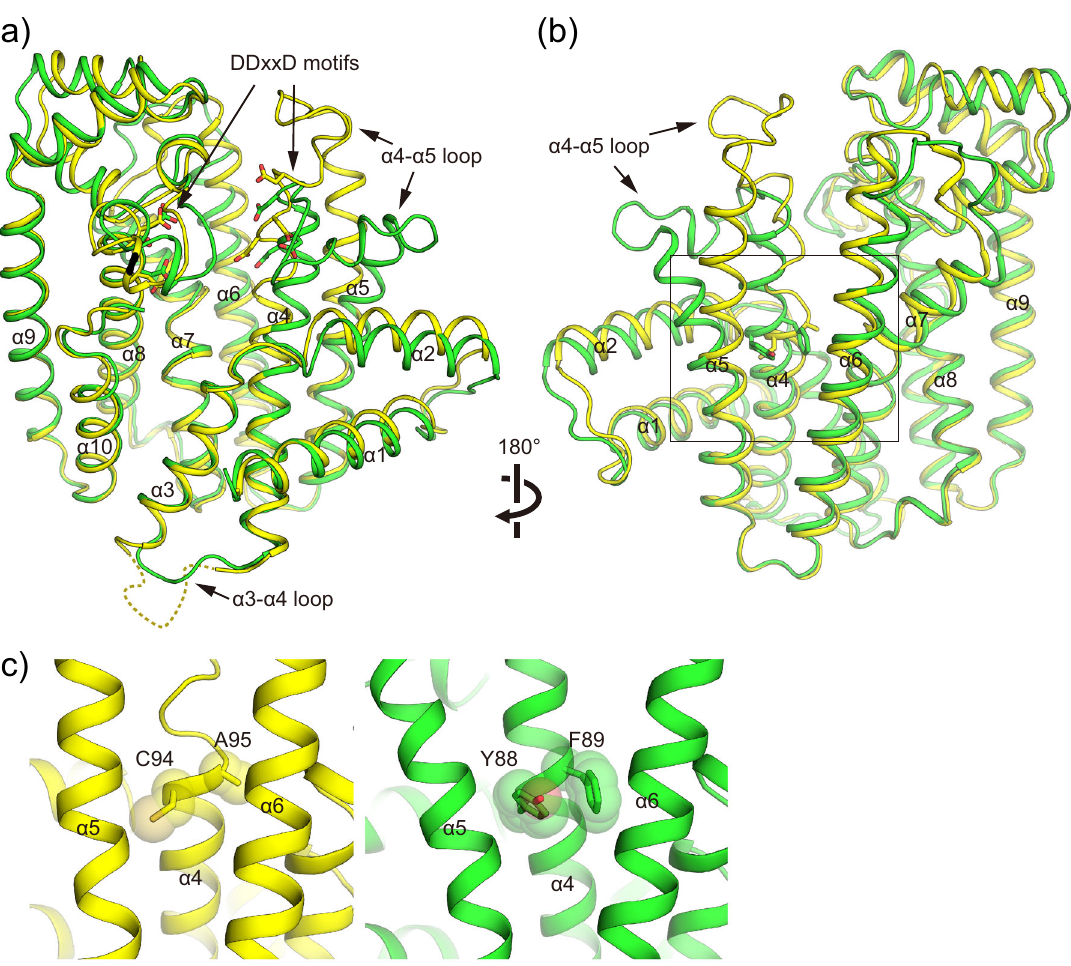
Fig. 5 Structural comparisons of EuTPT3 and EuFPS1. a Ribbon drawings of superimposed subunit structures of EuTPT3 (yellow) and EuFPS1 (green) are shown. DDxxD motifs are represented as stick model. The untraceable α 3 – 4 loop in chain A of EuTPT3 is represented as dashed line. b Side view of dimer interface. Cys94-Ala95 of EuTPT3 and Tyr88-Phe89 of EuFPS1 in α 4 helix are represented as stick model. c Close-up views around residues Cys94-Ala95 of EuTPT3 (left) and Tyr88-Phe89 of EuFPS1